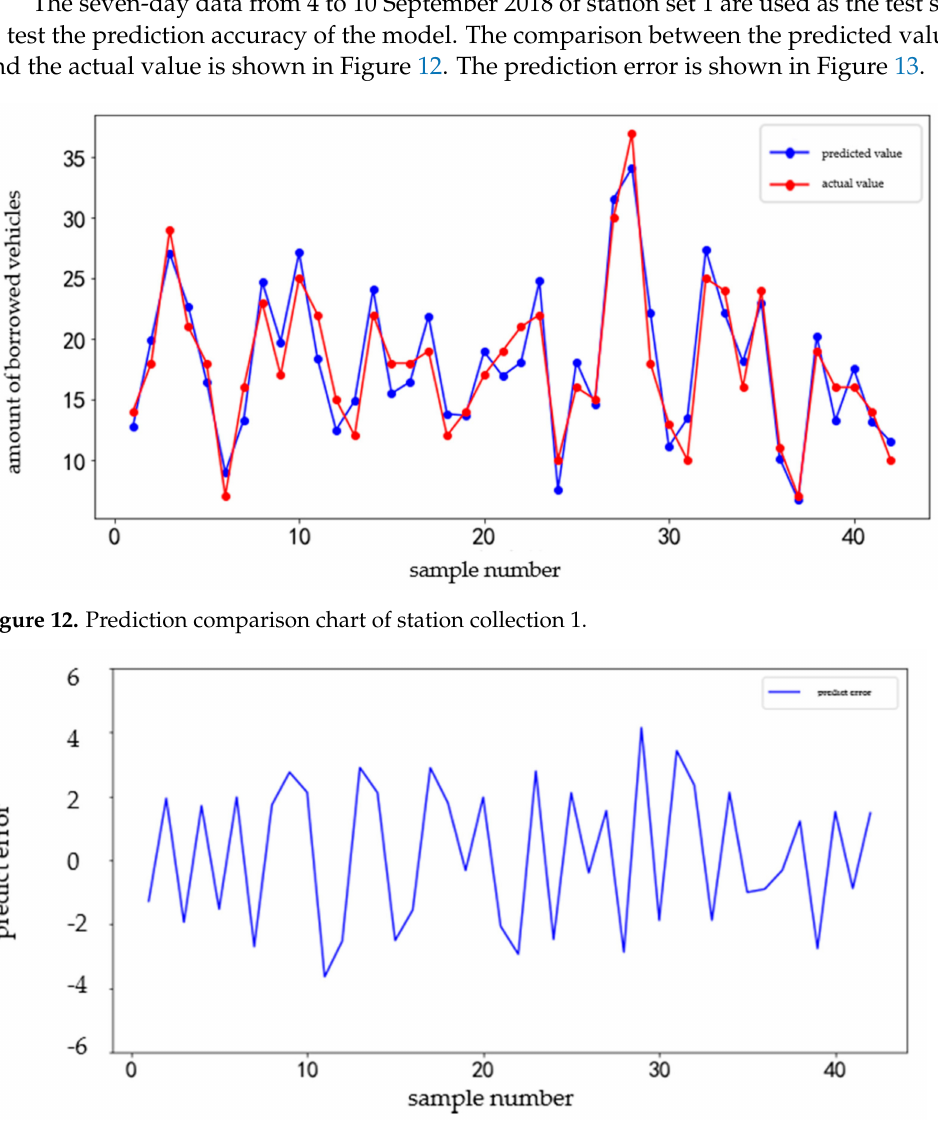
Figure 13. Error graph on station collection